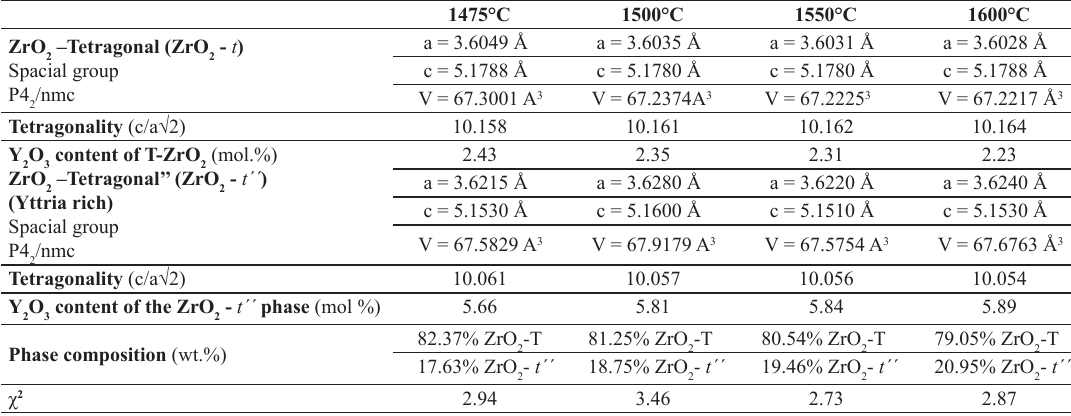
-3mol.%Y O + Fe O ) in regard to sintering temperature. 2 2 3 2 3